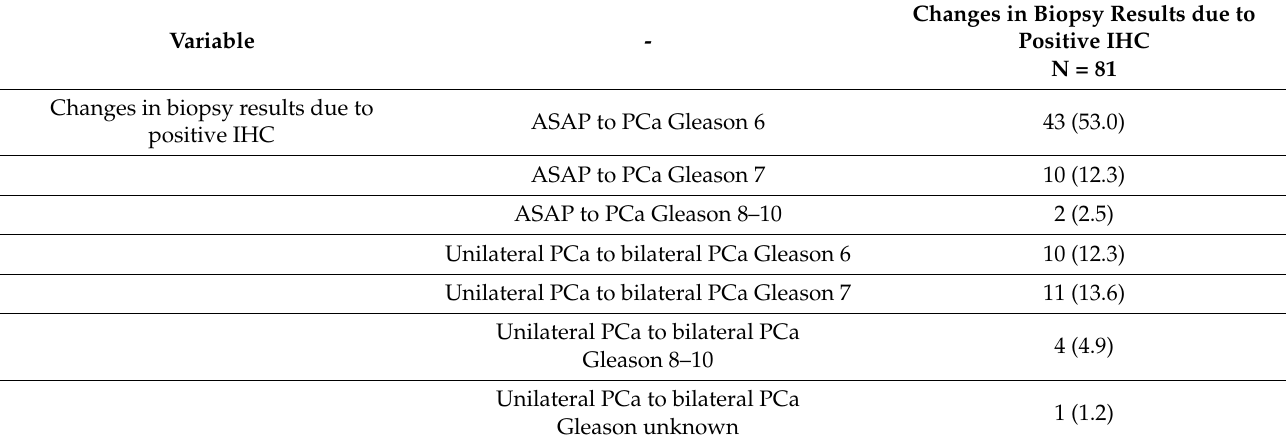
Table 3. Descriptive analyses of 81 patients with positive prostate biopsy, histological positive immunohistochemistry (IHC), and changes in biopsy results due to positive IHC at University Hospital Frankfurt between 01/2017–06/2020. Abbreviations: PCa—prostate cancer; ASAP—atypical small acinar proliferation; RP—radical prostatectomy; RT—radiotherapy; AS—active surveillance; ADT—androgen deprivation therapy; WW—watchful